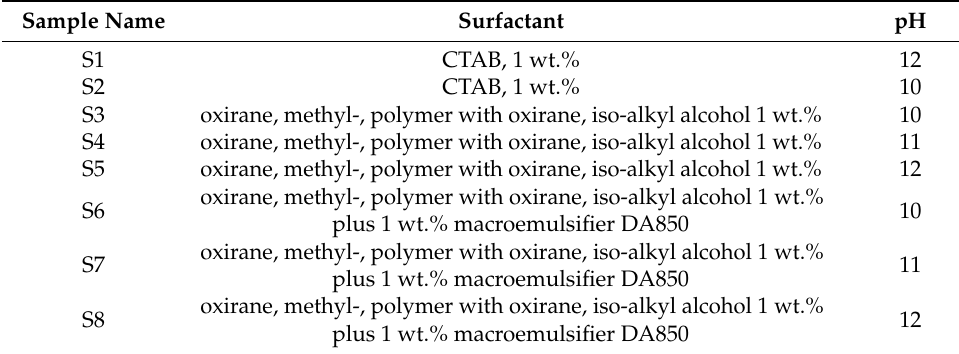
Table 3. Experiment sets for the small-scale cleaning